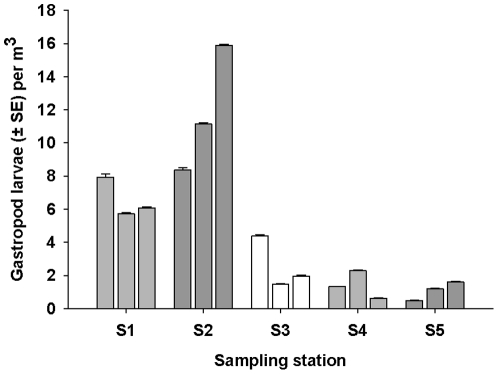
Mean number of gastropod larvae (± SE) per m3 of filtered seawater (n = 9) found at different distances from Kapiti Island (S1–S5).S1 = 1 km S, S2 = 0.5 km N, S3 = 5 km N, S4 = 15 km N, S5 = 50 km N.